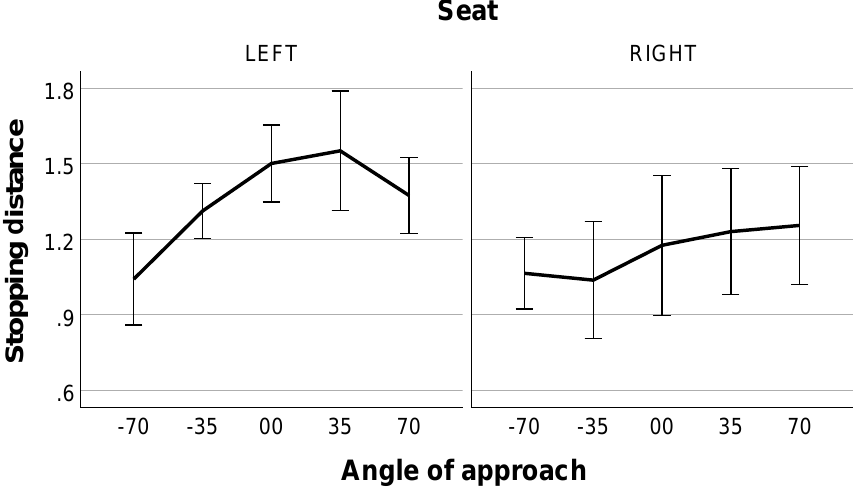
Figure 3. Average stopping distance (in meters) per angle of approach (ranging from − 70 ◦ to + 70 ◦ ) and seat in study 1: Whiskers represent 95% confidence